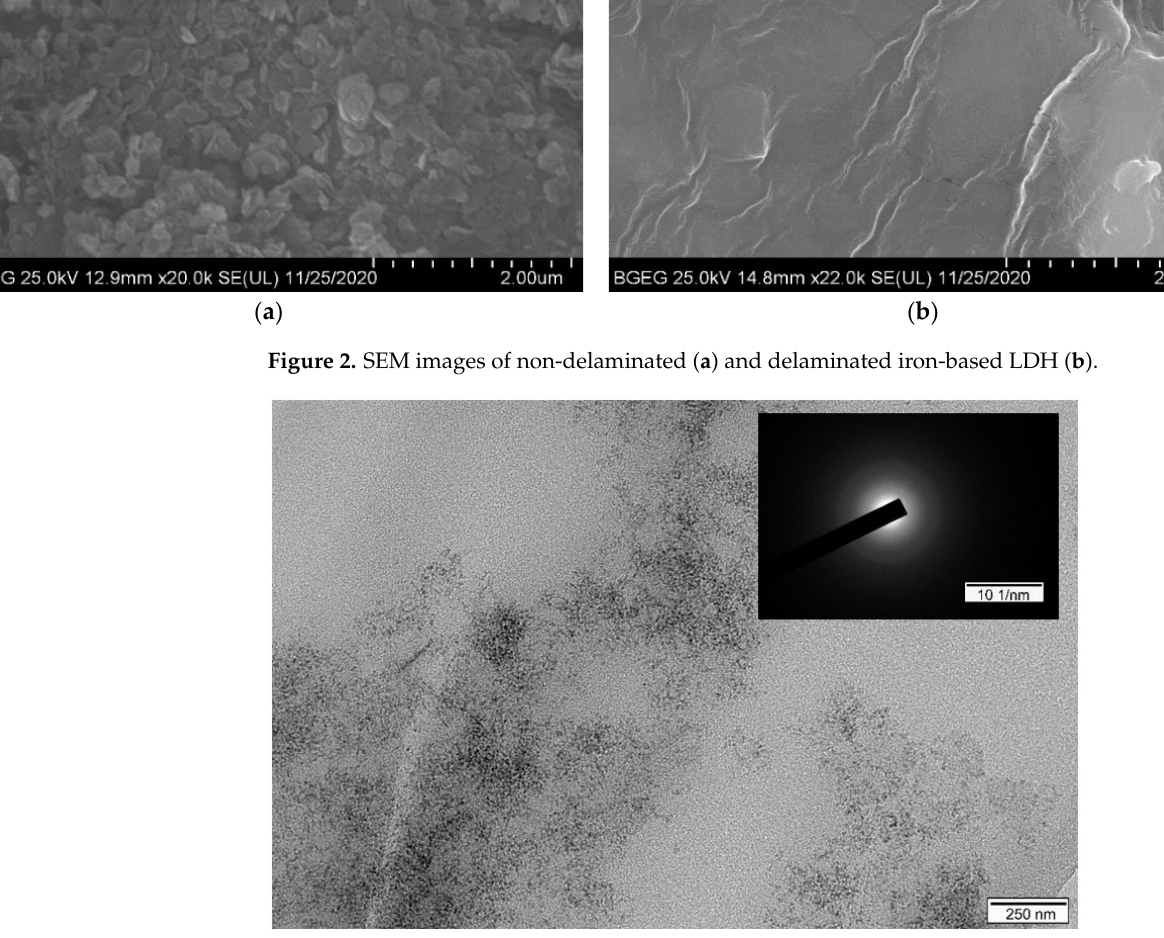
Figure 3. TEM image of delaminated iron-based LDH.